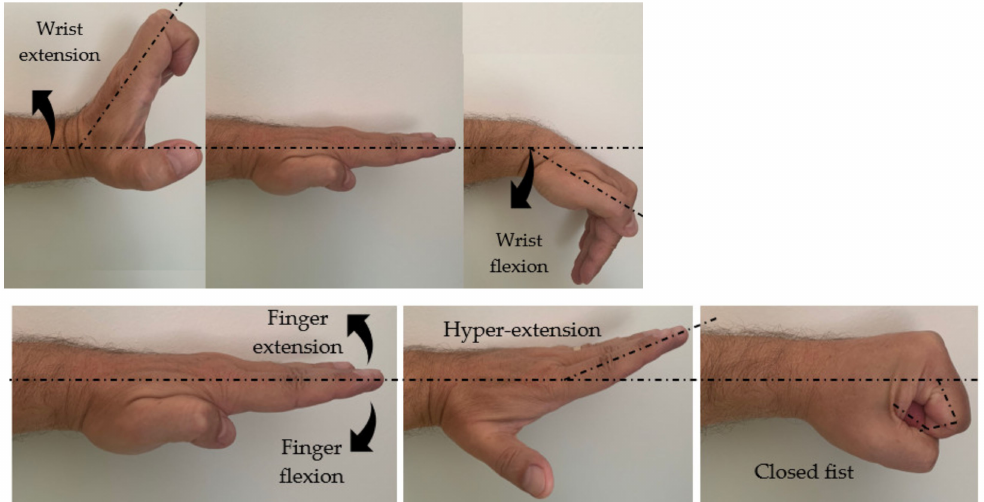
Figure 3. Flexion/extension of the wrist and joints of the